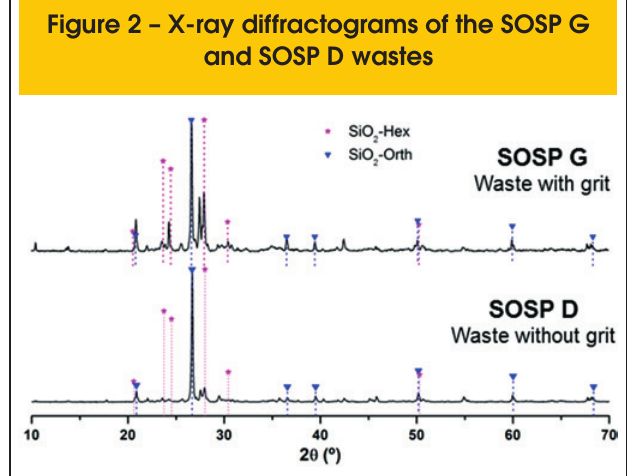
Figure 2 – X-ray diffractograms of the SOSP G and SOSP D